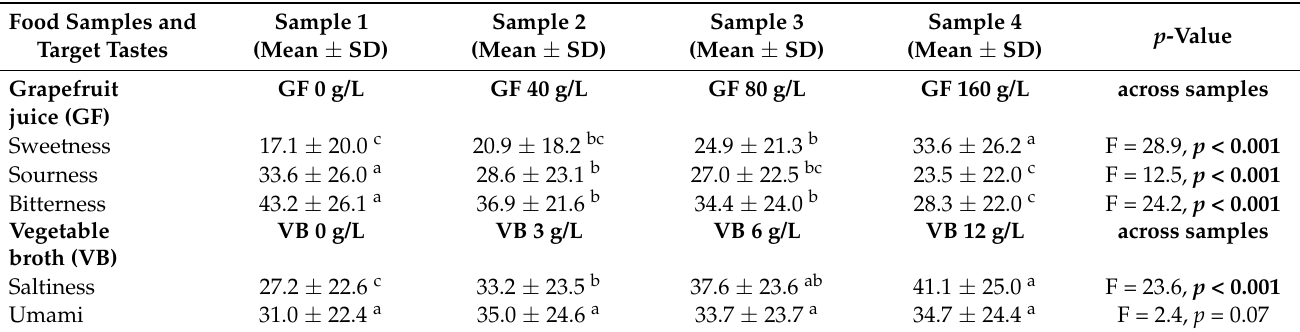
Table 1. Mean taste intensity ratings in model food samples with increasing tastant concentrations (sucrose in grapefruit juice, sodium chloride in vegetable broth).